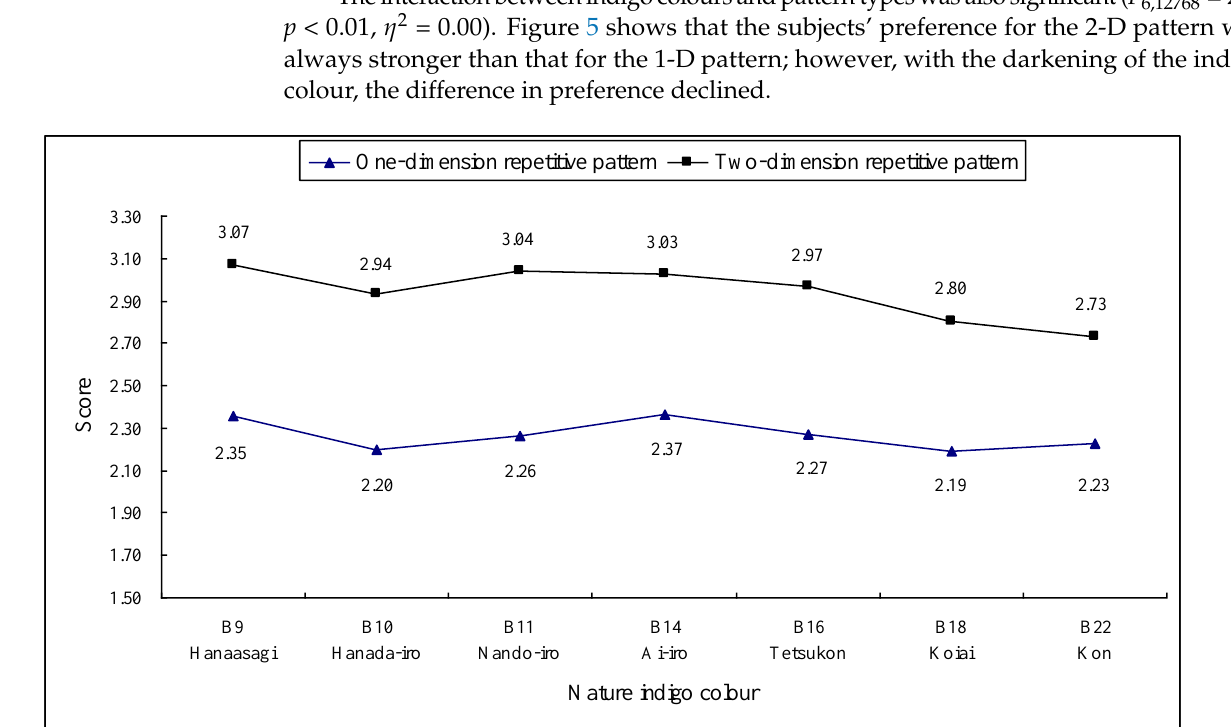
Figure 5. Interaction between dye colours and pattern types. The main effect of floral pattern size was significant ( F 3,12768 = 58.91, p < 0.01, η 2 = 0.01), and the results of Tukey’s post-test at α = 0.05 demonstrated that the subjects exhibited the strongest preference for the large pattern size (L, 2.81) and the weakest preference for the extra small pattern size (XS, 2.44) (see Table 5). Table 5. Tukey grouping of preferences for different floral pattern sizes.